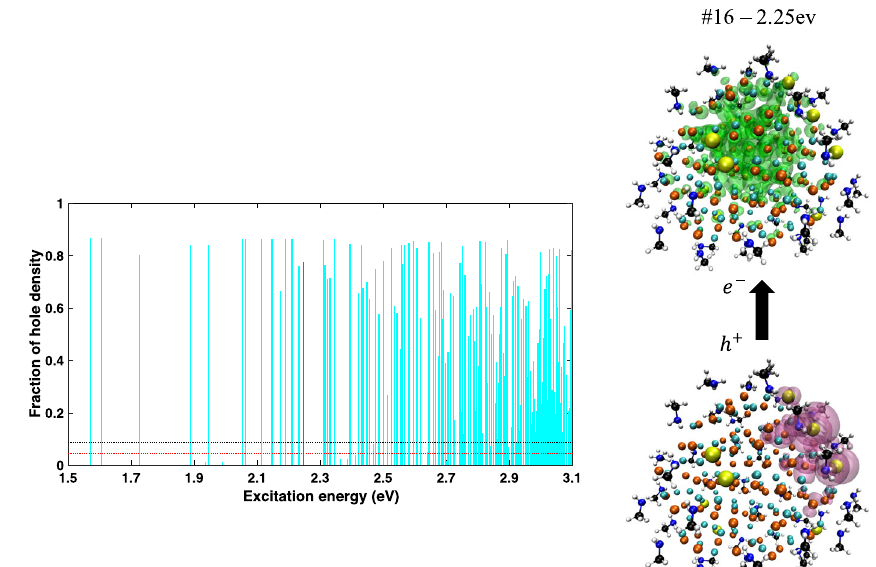
Fig. 4 Effect of undercoordinated Se atoms on the excited states of Cd 91 Se 91 . Left: Fraction of hole charge density on the eight Se atoms that are two- coordinate in the Cd 91 Se 91 NC with methylamine ligands. The red and black dotted lines illustrate the expected fraction based on the assumptions that the hole is distributed equally among all Se or all Cd and Se atoms, respectively. Clearly, most of the low-energy states preferentially localize on the two- coordinate Se atoms. Right: Attach (green) and detach (magenta) densities of the 16 th excited state (marked with a magenta line in the left hand fi gure). The undercoordinated Se atoms are highlighted in yellow. Clearly the hole is speci fi cally localized near a subset of these